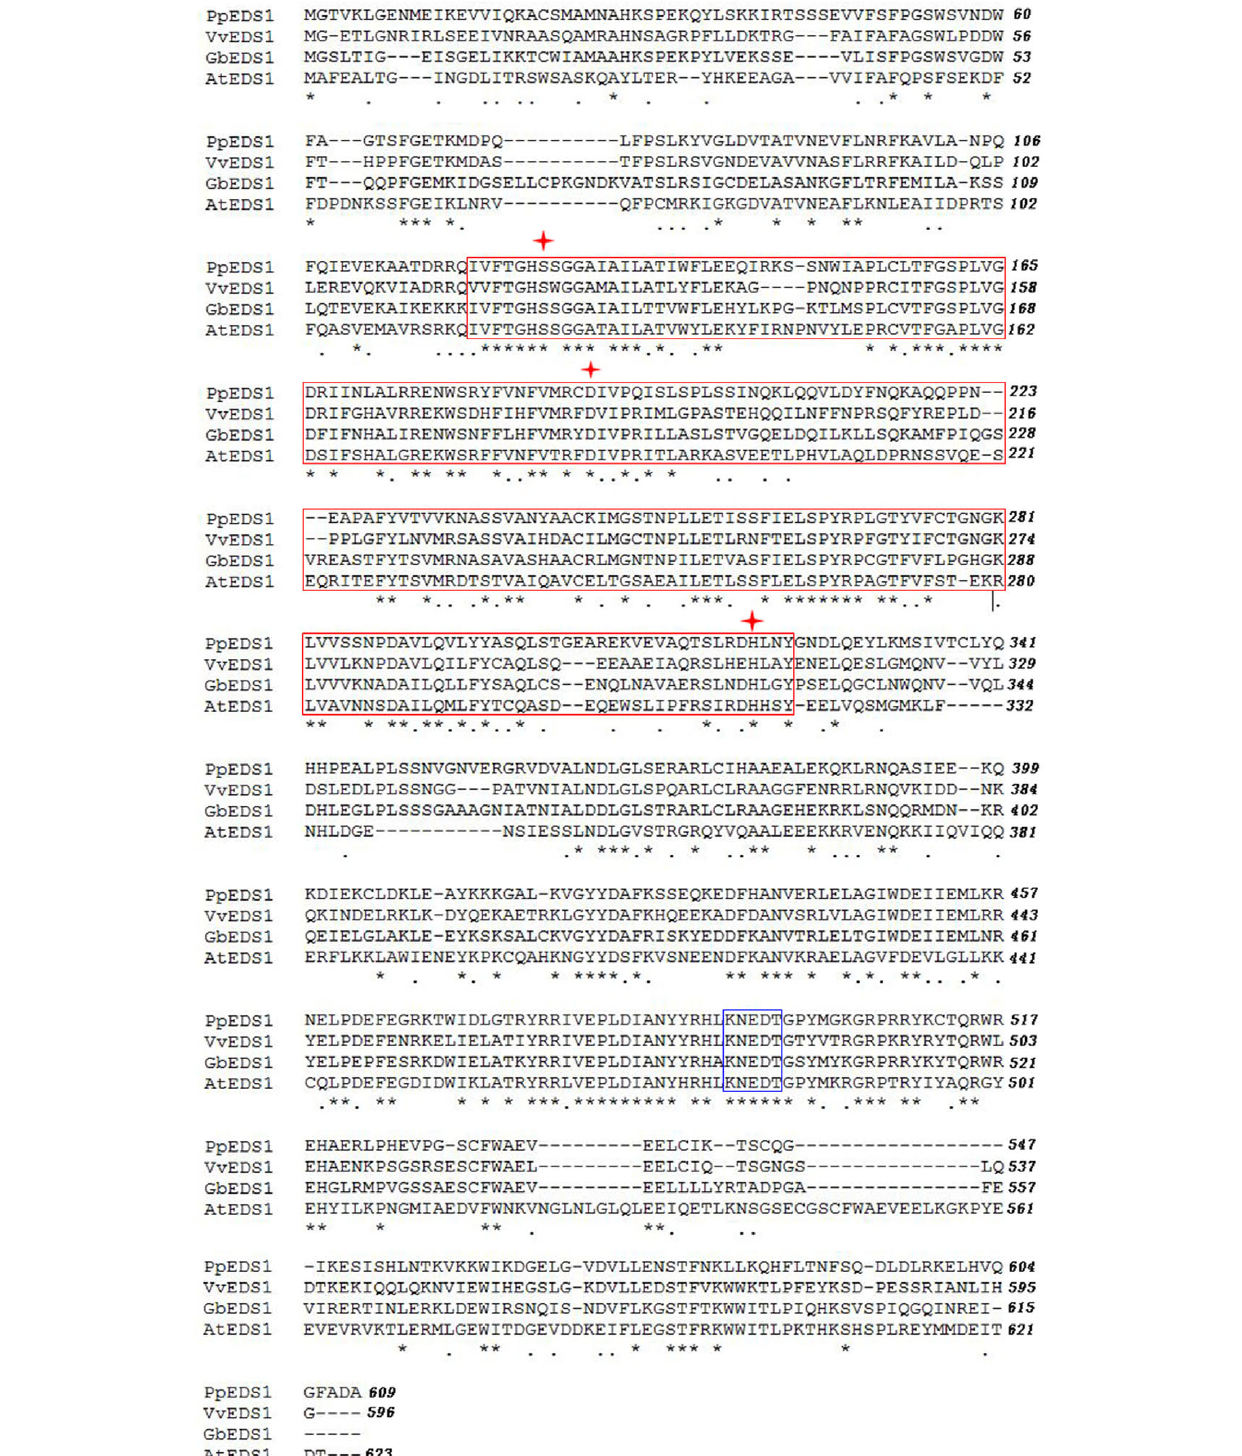
Frontiers in Plant Science |